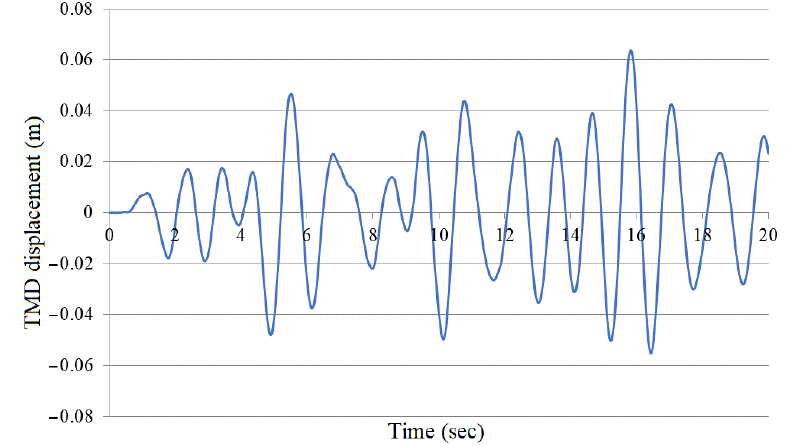
Figure 23. TMD displacement.